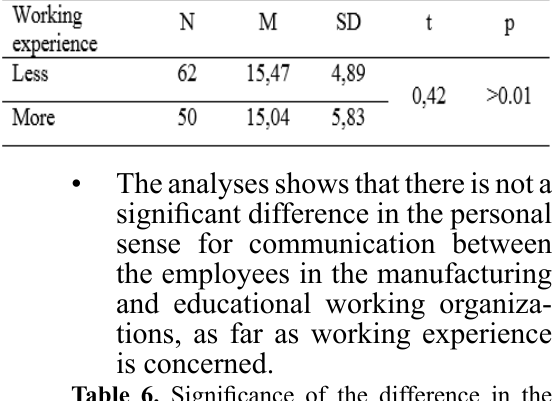
Table 8. Significance of the difference in the personal sense for communication between the employ - ees in the manufacturing and educational working orga - Table 5. Significance of the difference in the assessment of the working environment by the employ - nizations, depending on their level of ees in the manufacturing and educational working orga - nizations, as far as the working experience is concerned